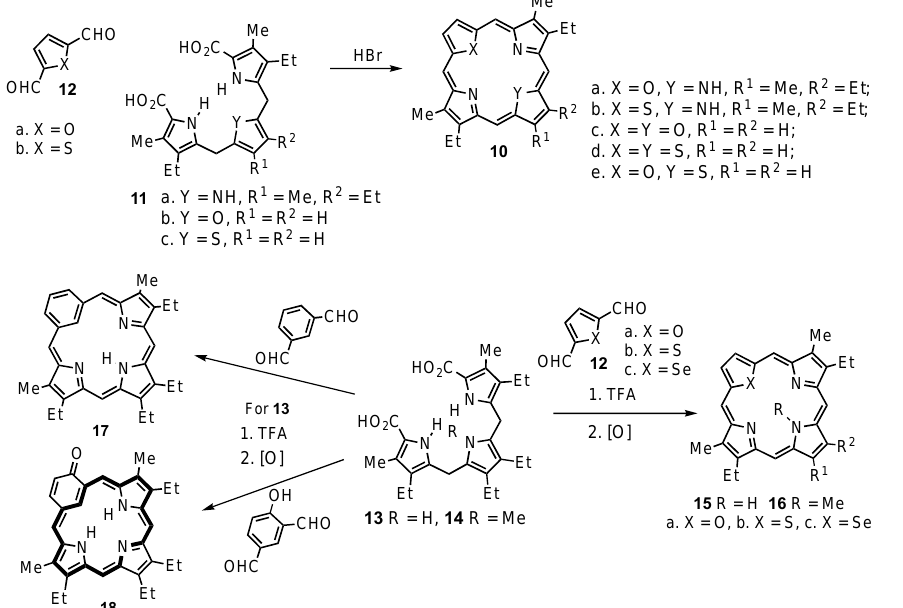
Scheme 3. Example of MacDonald- type ‘3 + 1’ syntheses of porphyrin analogues.